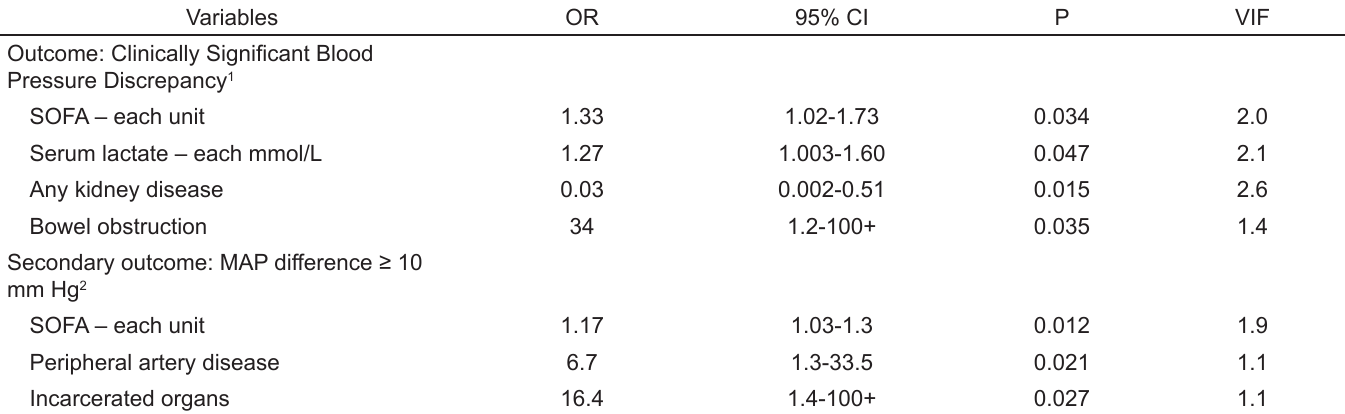
Table 3. Results from forward stepwise multivariable logistic regression measuring association between clinical factors and the likelihood of clinically significant discrepancy between NIBP and IABP*. All predetermined factors were entered into the models and only factors with significant association were reported. The models for each outcome measure showed both good fit of the independent variables and good discriminatory capability (higher